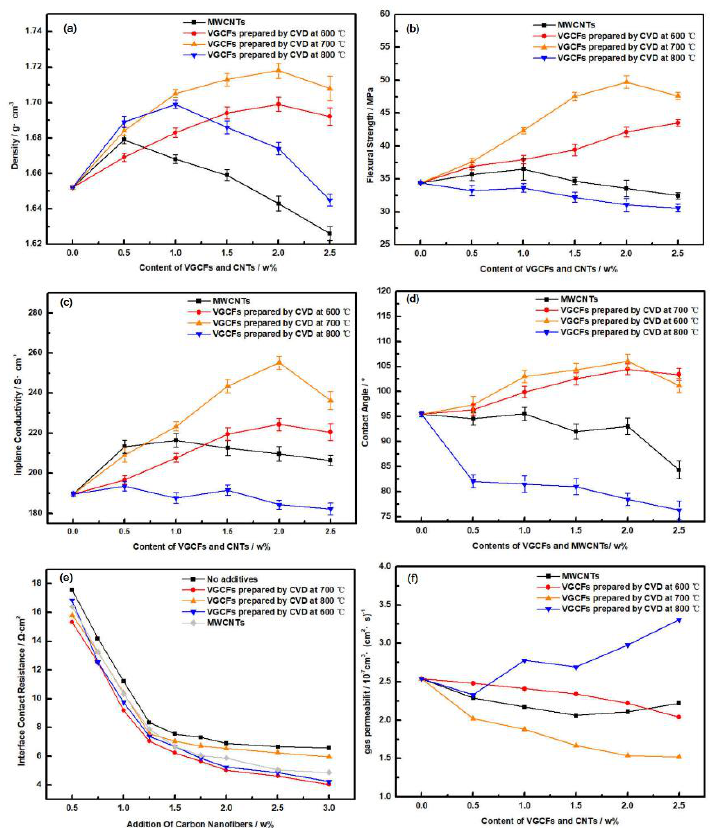
Figure 5. The effect of adding VGCFs on the performance of composite BPs.( a ) density; ( b ) flexural strength; ( c ) in-plane conductivity; ( d ) contact angle; ( e ) ICR; ( f ) hydrogen permeability.